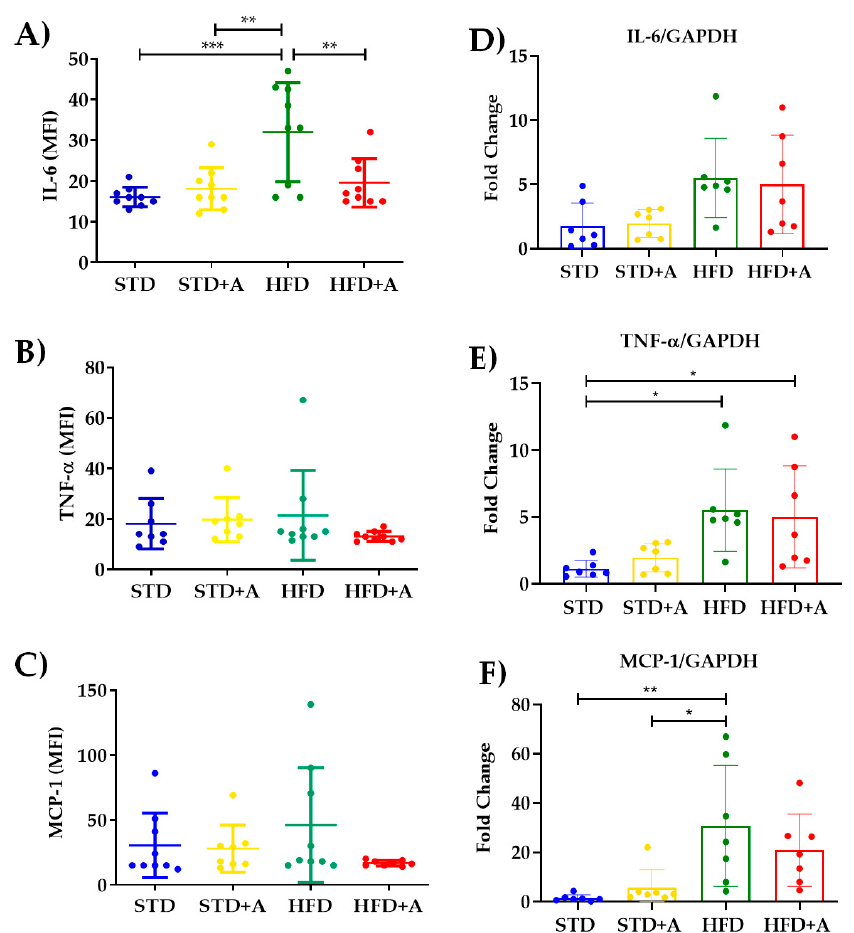
Figure 6. Alliin e ff ect on proinflammatory cytokines. ( A ) Alliin demonstrated its anti-inflammatory capacity by decreasing the levels of IL-6 in the HFD + A group in a significant manner (** p < 0.01); ( B ) TNF α and ( C ) MCP-1 levels. ( D ) IL-6 gene expression did not have any di ff erence, and ( E ) TNF α had di ff erences between the STD and HFD and HFD + A groups, and a similar result was seen in ( F ) MCP-1 with di ff erences in HFD vs. STD and STD + A groups. * p < 0.05, *** p < 0.001. STD, standard diet group; STD + A, standard diet + alliin treatment group; HFD, high-fat diet group; HFD + A, high-fat diet + alliin treatment group. For gene expression, each sample 2 - ∆∆ CT was calculated and analyzed by one-way ANOVA / Tukey’s test. One-way ANOVA / Tukey’s test was also performed for cytokine serum levels. Values shown as mean ±